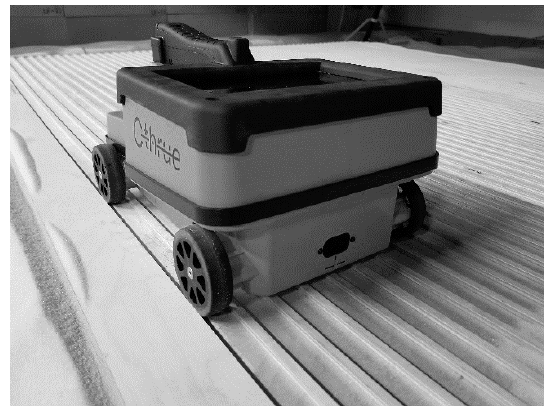
Figure 2. Illustration of C-Thrue sensor on the gridded platform to limit encoder slippage. The distance between the center of each wheel track is 2.5 cm. The sensor dimensions are 20 cm wide by 30 cm long.